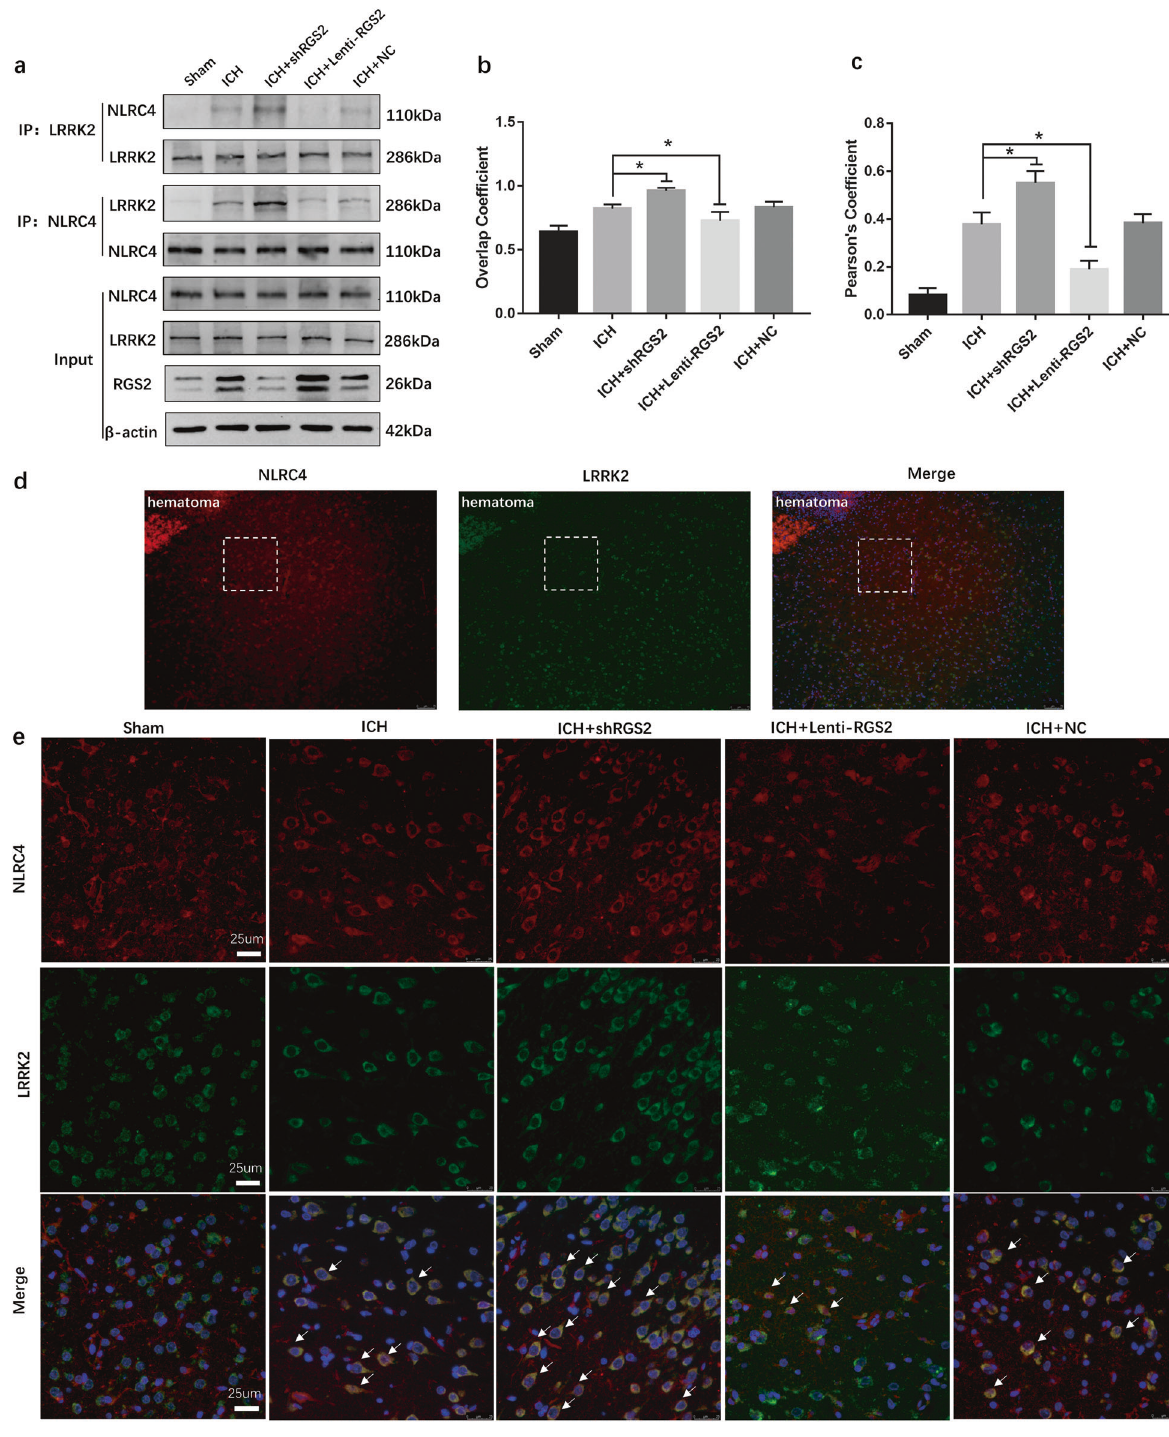
Fig. 8 RGS2 affected the interaction of NLRC4 and LRRK2 following ICH. a Co-Immunoprecipitation assay for NLRC4 and LRRK2, d The location of the image around the perihematomal area e Representative images of Immuno fl uorescence (IF) colocalization for NLRC4 and LRRK2. b , c Pearson ’ s coef fi cient and overlap coef fi cient for NLRC4 and LRRK2 in peri-hematoma area in ICH, Sham, ICH + shRGS2, ICH + Lentil- RGS2 and negative control lentiviral (ICH + NC) groups at 72 h after ICH (six rats for each group). * P < 0.05, compared with